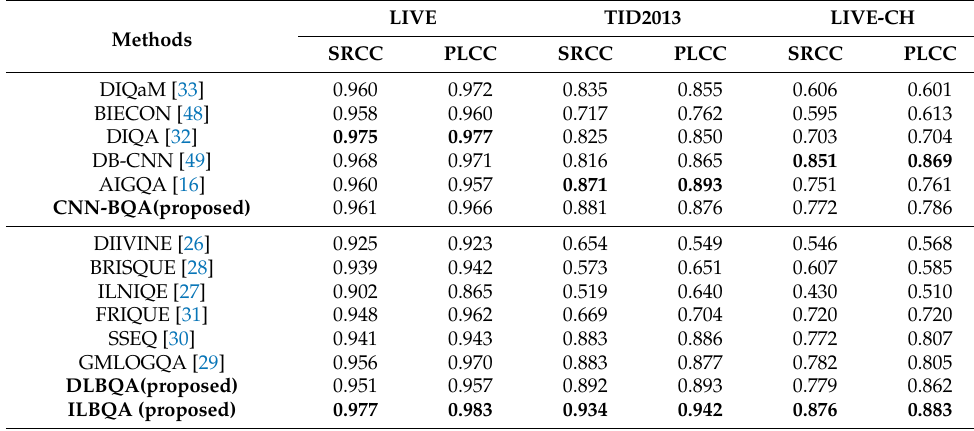
Table 8. Performance comparison on three benchmark IQA